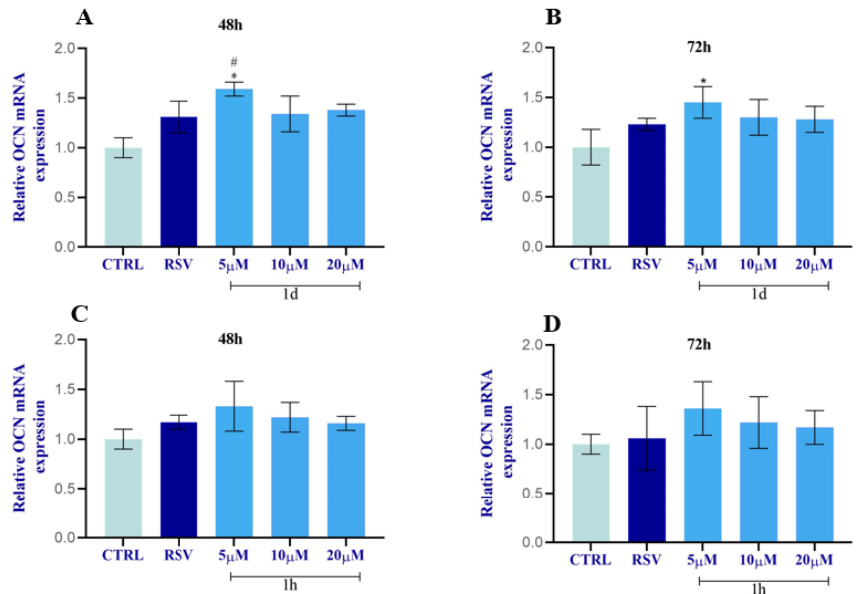
Figure 17. Effects of 1d ( A , B ) and 1h ( C , D ) on OCN expression at 48 h and 72 h. The histograms represent normalized data for the housekeeping βACT. The values represent the average of three independent experiments with the relative SD (Error bars). * Significance with respect to CTRL, * p < 0.05; # significance with respect to RSV, # p < 0.05.